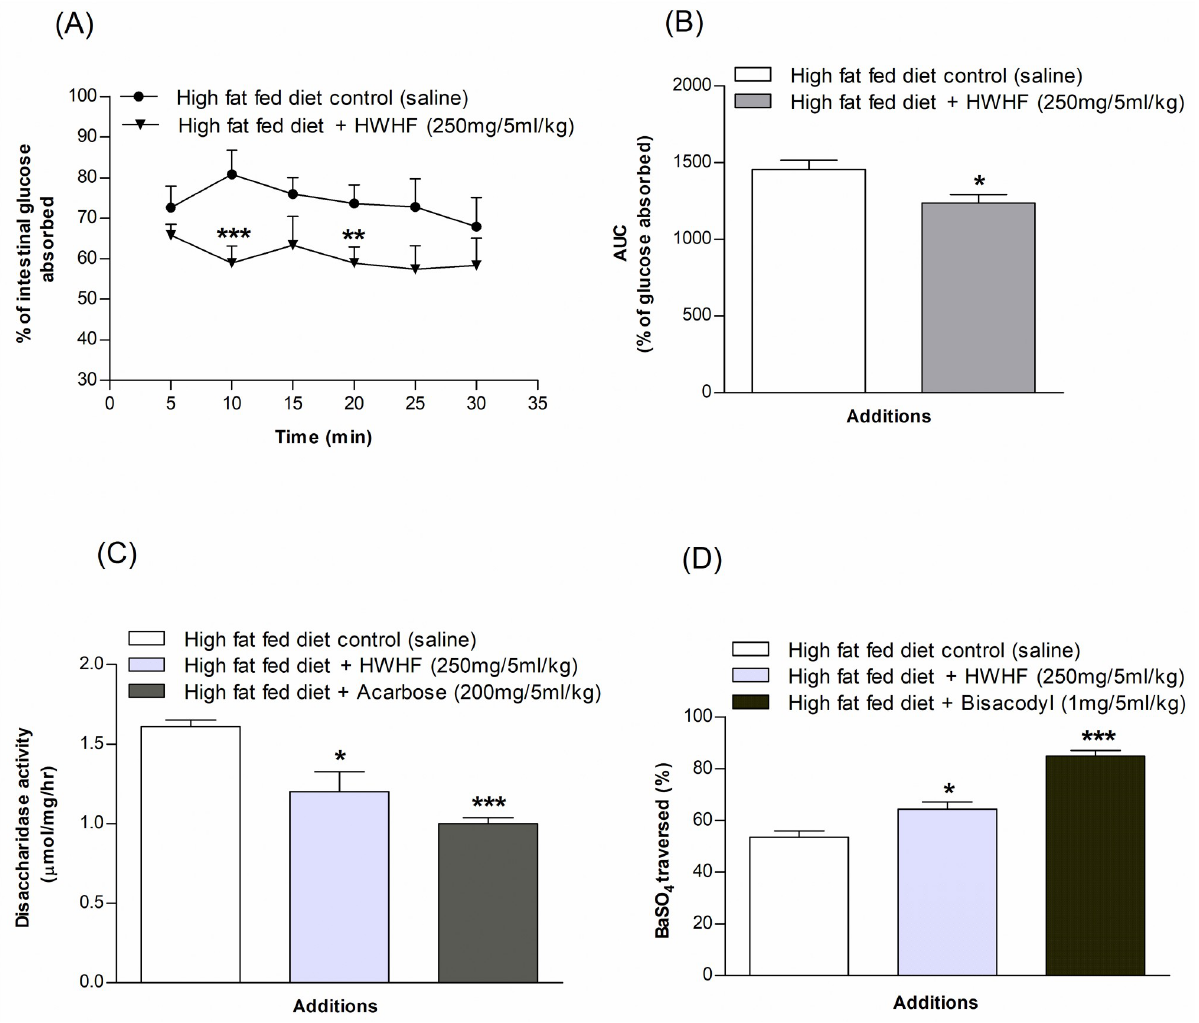
Fig 5. Effects of HWHF on (A & B) gut perfusion, (C) intestinal disaccharidase enzyme activity and, (D) GI motility in high fat fed rats. Rats were fasted for 36 h, and intestinal perfusion was performed with glucose (54 g/l) with or without HWHF (250 mg/5ml/kg, b.w.). BaSO4 was administered